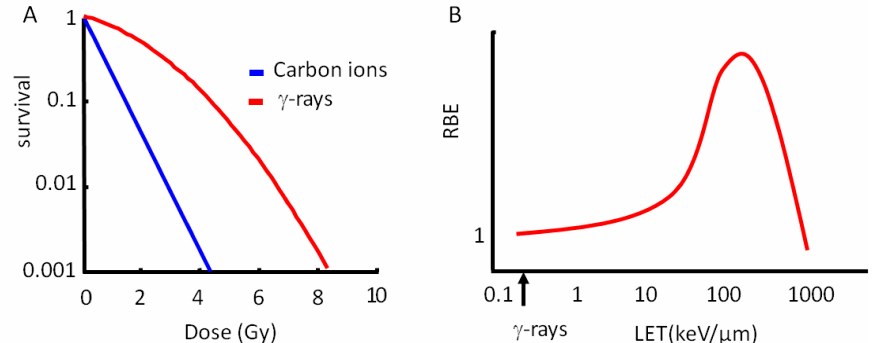
Figure 18. Typical dose response curves of survival of cultured mammalian cells exposed to γ -rays and ion particles with LET of ~100 keV/ μ m ( A ); Typical relative biological effectiveness—linear energy transfer (RBE-LET) relationship demonstrating that RBE peaks near 100–200 keV/ μ m ( B